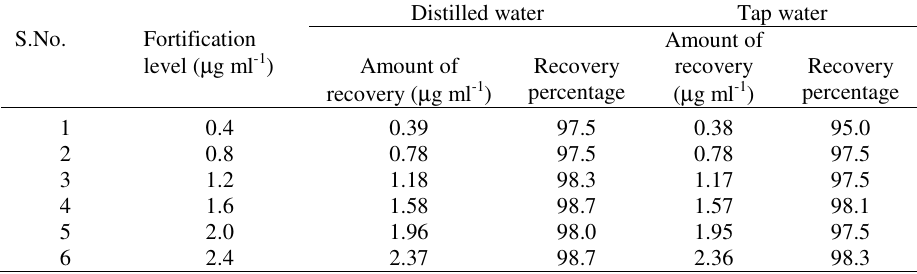
Distilled water Tap water